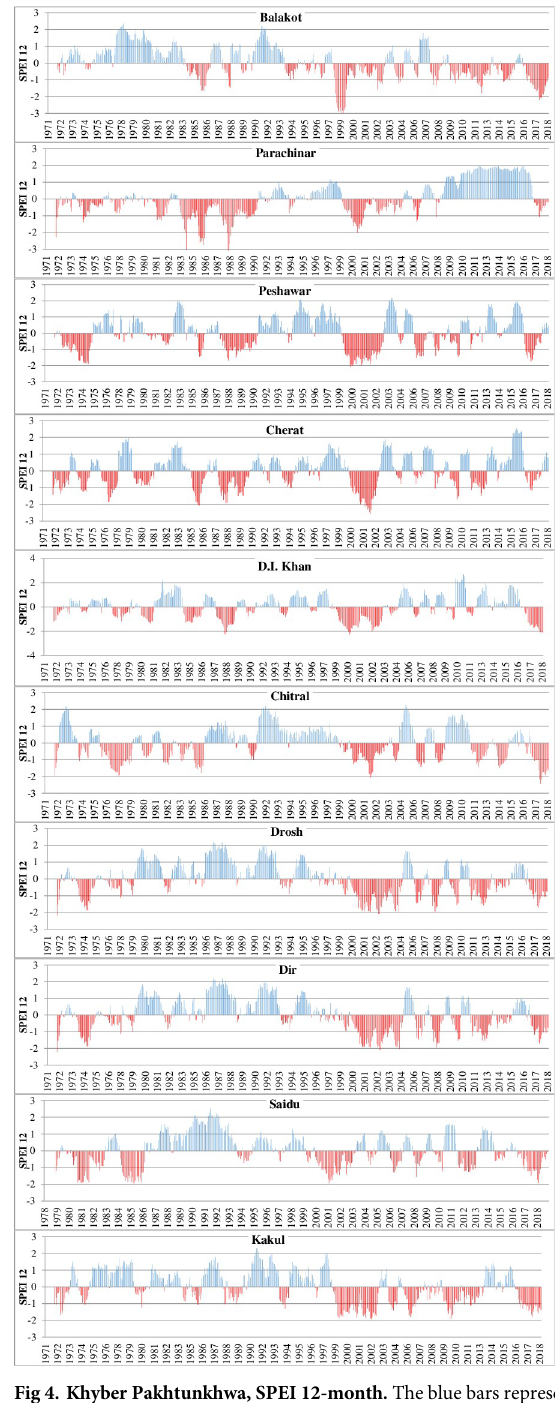
Fig 4. Khyber Pakhtunkhwa, SPEI 12-month. The blue bars represent wet period while the red shows dry. positive but insignificant trend in the maximum at the meteorological stations of the area. This indicates an increase in precipitation in the month of February in the study area. In March, the Balakot and Saidu met-stations exhibited a significant negative trend in the 1-month SPEI